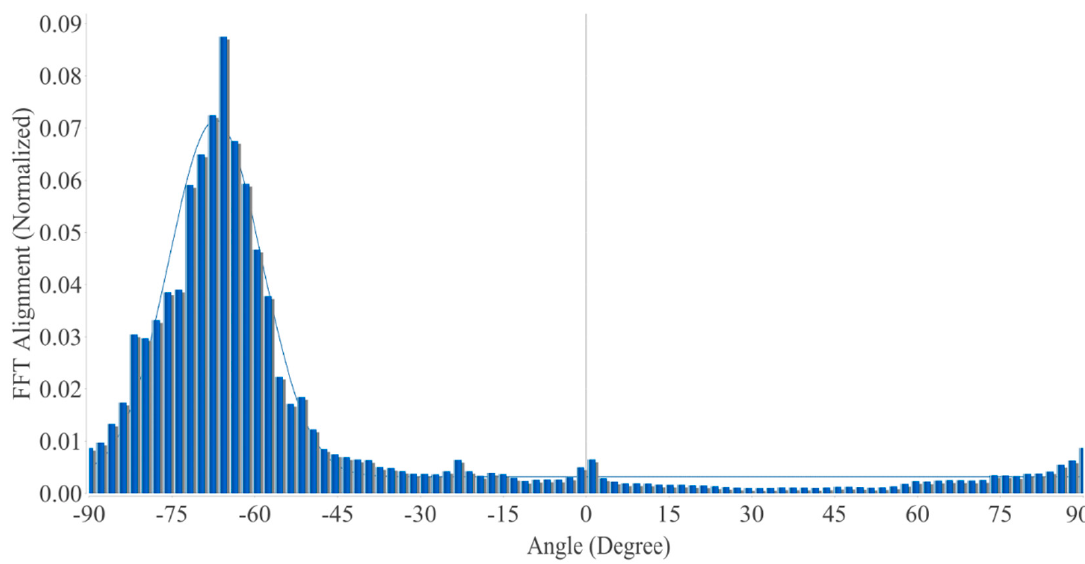
Figure 5. Alignment of the PA6 nanofibers.